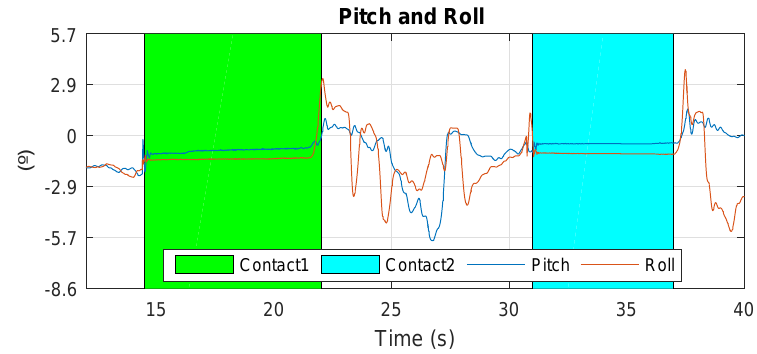
Figure 13. Pitch and roll—Cartuja bridge experiments.